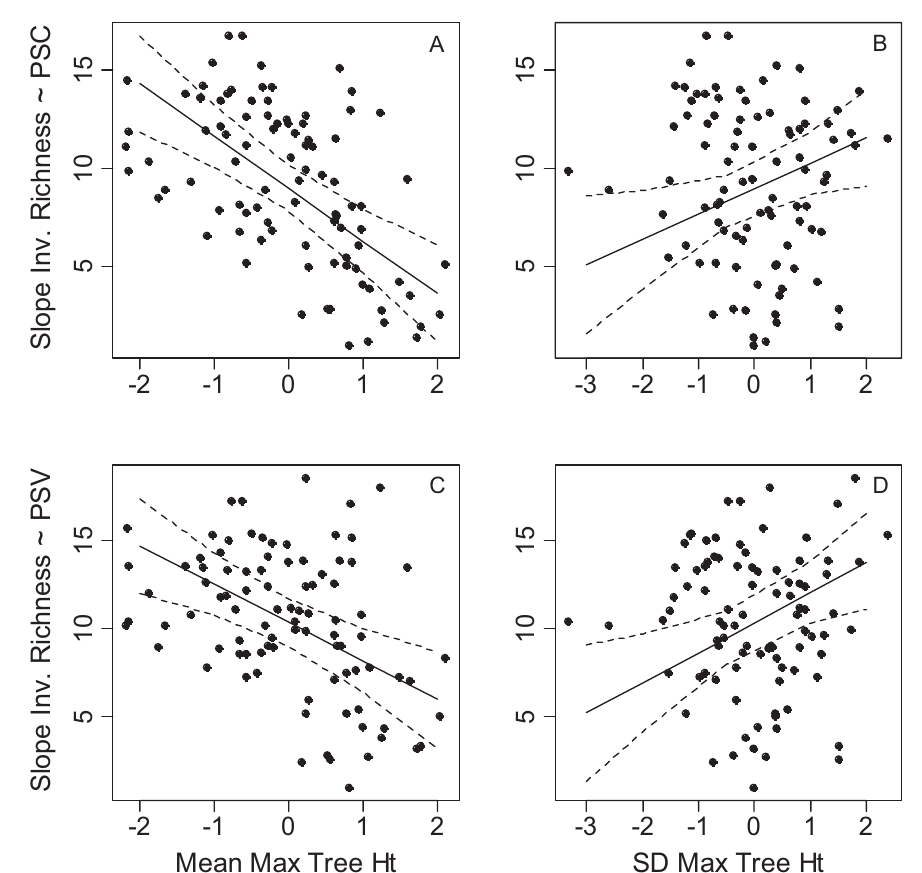
Figure 2. Effects of mean and SD maximum tree height in 91 ecological sections on the degree to which PSC ( A, B ) and PSV ( C, D ) affect invasive species richness (i.e. slope values for these relationships). Note that values on x and y axes were transformed (z-transformed and [(x + abs(min(x)) + 1) 7 ], respectively) pri- or to analysis. Untransformed values for slopes were largely negative (Fig. 1; Suppl. material 3, fig. S3.1).